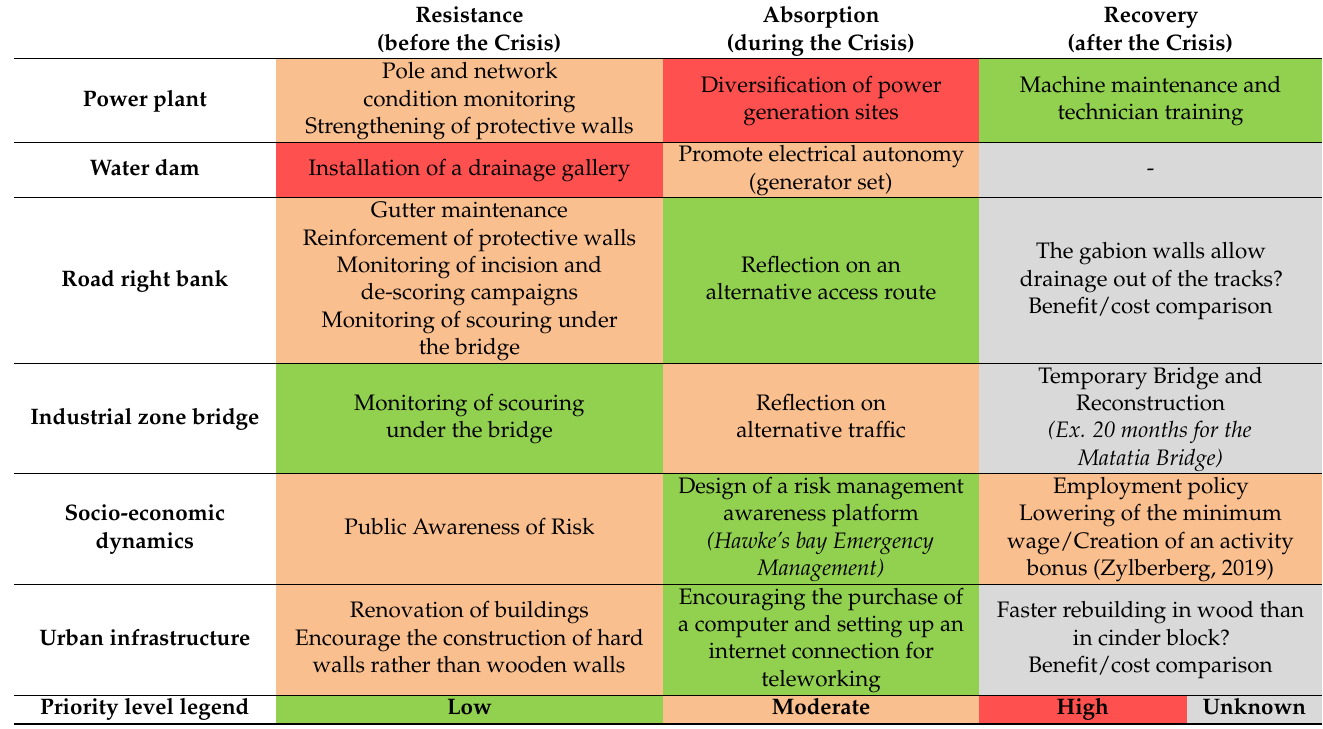
Table 5. Synthesis of ideas to improve technical, social and urban resilience in the Punaruu